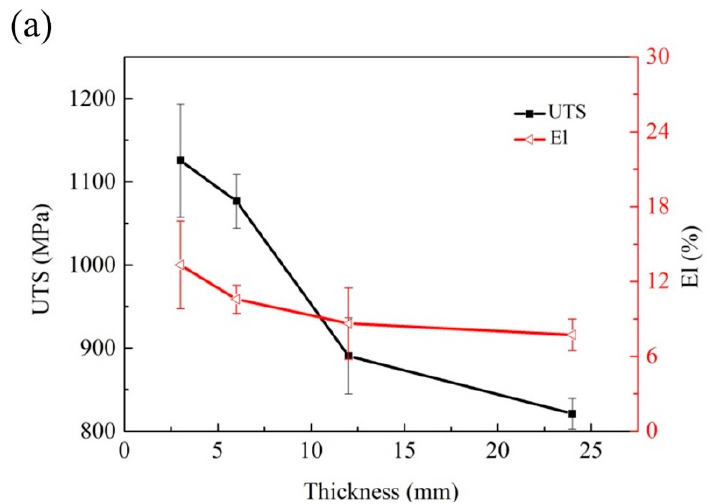
Figure 11. Cont. Figure 11.